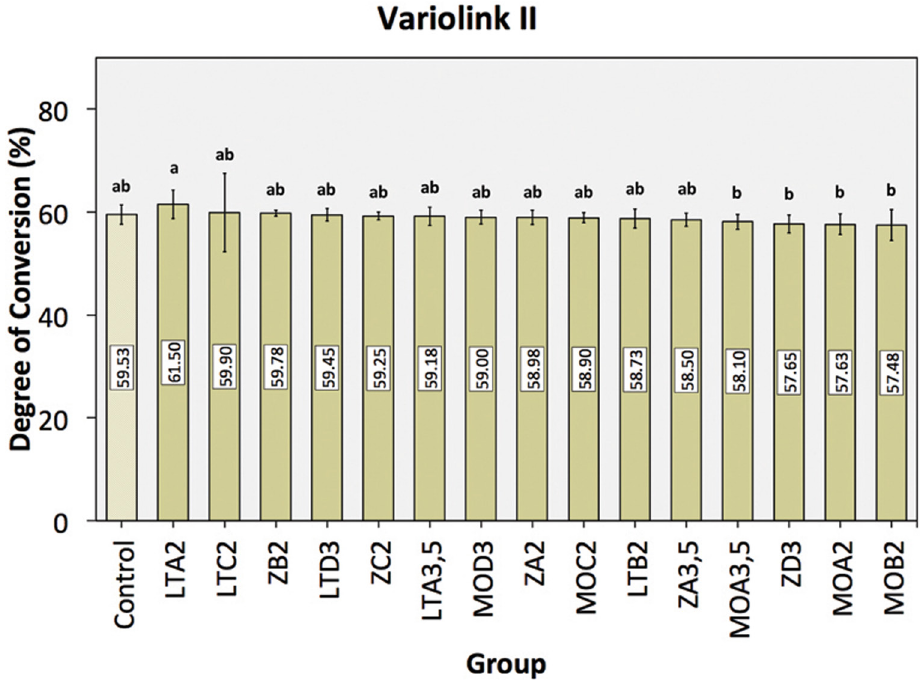
Figure 5- Mean DC percentage ± confidence interval of Variolink II as a function of ceramic composition and ceramic shade. *Identical letters indicate statistically homogeneous groups